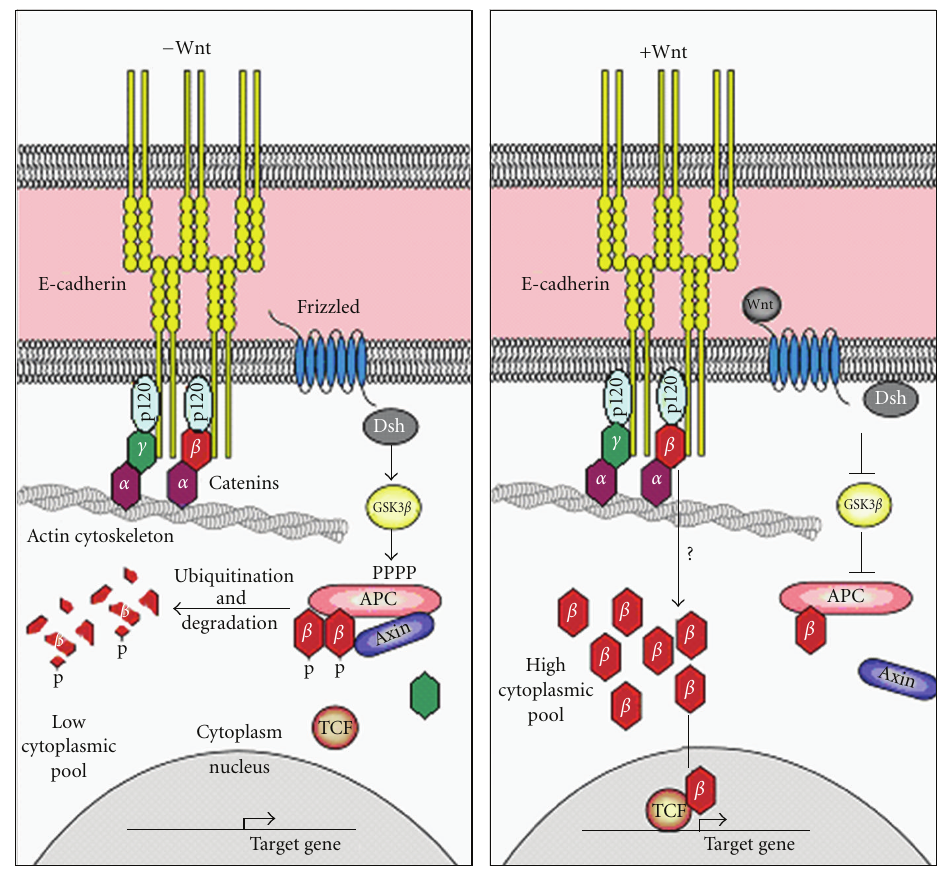
Figure 1: E-cadherin/ β -catenin complex in epithelial cell-cell adhesion and Wnt